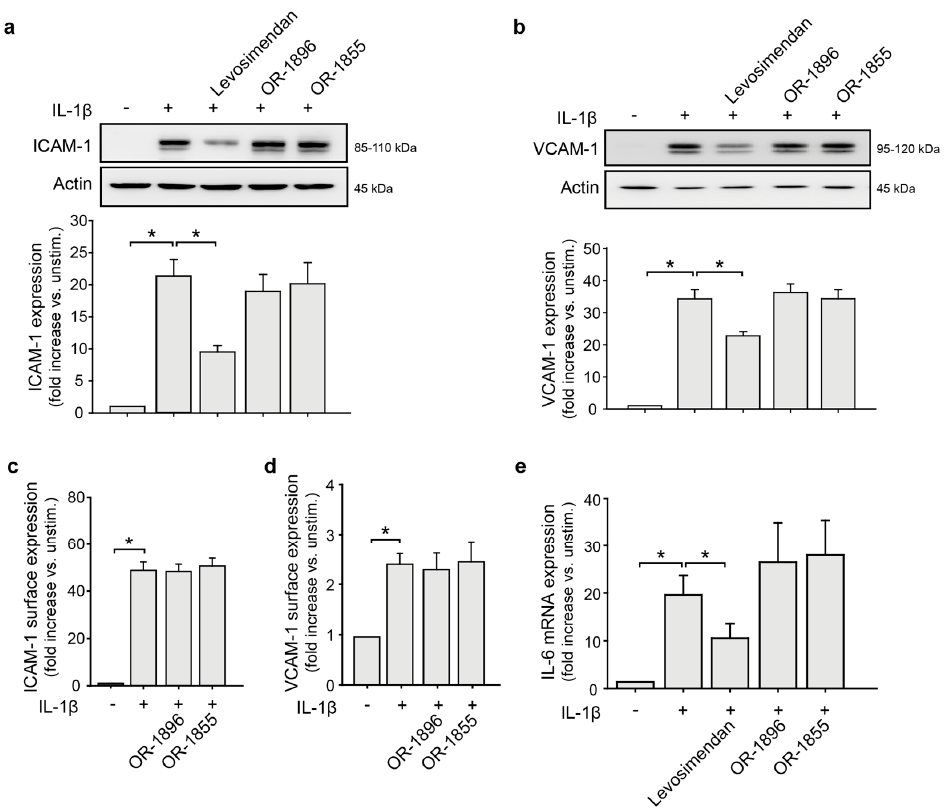
Figure 1. Effect of levosimendan and its metabolites on the pro-inflammatory endothelial phenotype. Endothelial cells were pre-incubated with levosimendan, OR-1855, OR-1896 (10 µ M; 30 min.) or sham solution (DMSO v / v ) followed by stimulation with IL-1 β (10 ng/mL) for 4 h. Levosimendan reduced the expression of ( a ) ICAM-1 (n = 10; p > 0.05) and ( b ) VCAM-1 (n = 17; p < 0.05), as detected by western blot, whereas the metabolites had no effect (n = 9–10 and n = 17, respectively). The graphs show protein band densities of ICAM-1 and VCAM-1 normalized to actin (* p < 0.05). ( c ) IL-1 β -induced cell surface expression of ICAM-1 (n = 12; * p < 0.05) was not affected by OR-1896 or OR-1855 treatment (n = 12). ( d ) Treatment with OR-1855 or OR-1896 (n = 14–18) did not reduce IL-1 β -dependent (n = 18; * p < 0.05) VCAM-1 surface expression as assessed by flow cytometry. ( e ) IL-6 mRNA expression was impaired upon treatment with levosimendan (n = 12; * p < 0.05) but not with OR-1855 or OR-1896 treatment (both n =